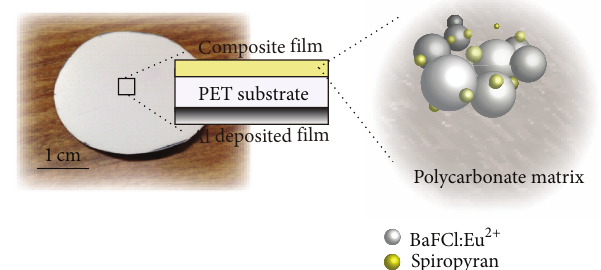
Figure 2: Photograph showing the composite (SP/BaFCl:Eu 2+ PC as binder)/PET/Al three-layered film and schematic diagrams of its cross-section and internal